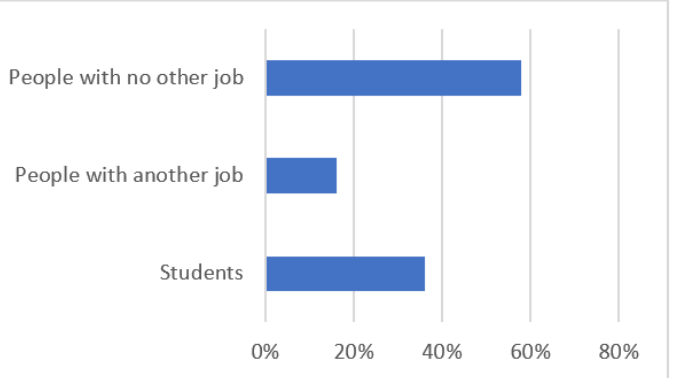
Figure 1. Profile of the couriers in Paris in 2018. Source: Survey by the authors.